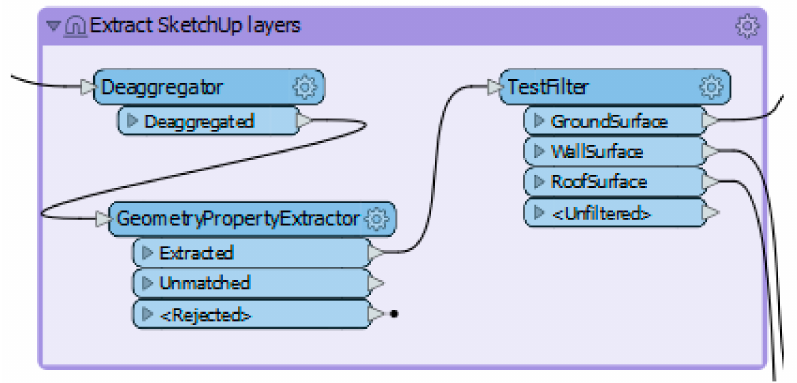
Figure 8. Layer extraction from SketchUp file conducted in